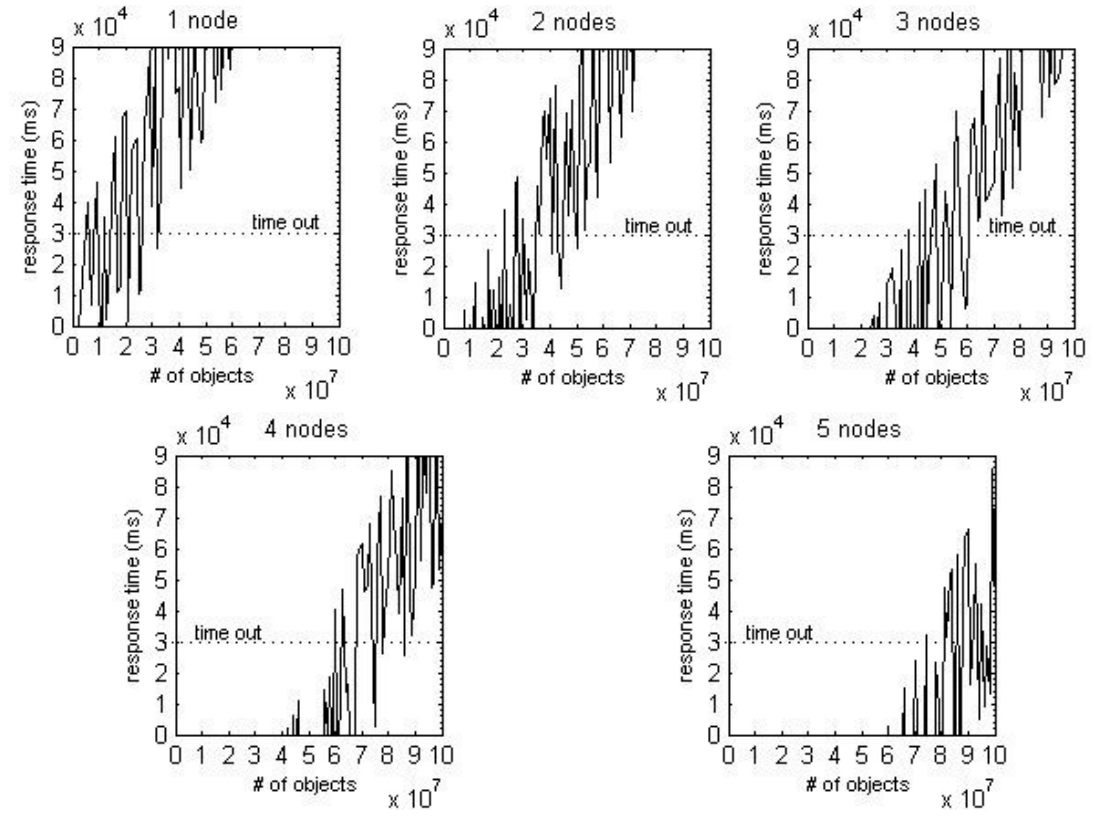
Figure 11. Response time for each cluster.